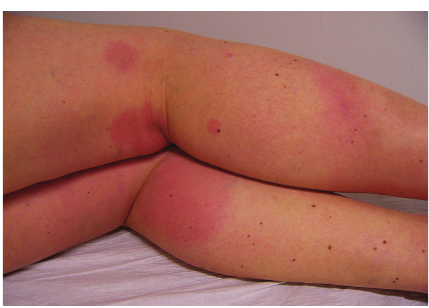
Figure 2: Multiple